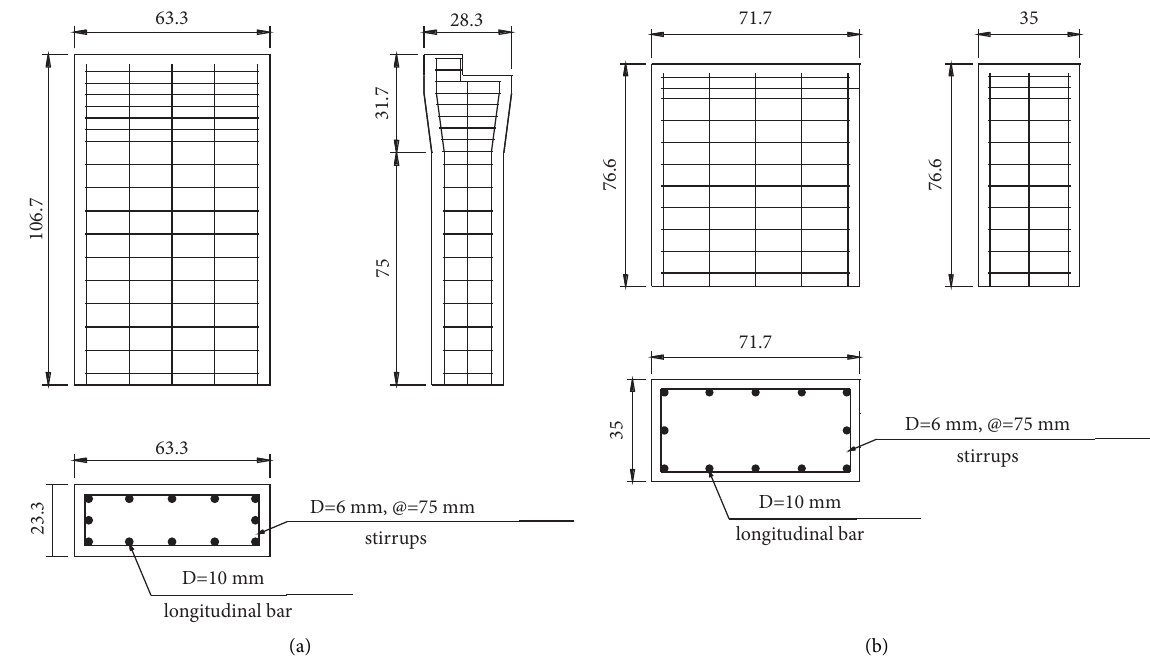
Figure 7: Specimen of pier drawings for (a) side piers (Pier-1 and Pier-4) and (b) main piers (Pier-2 and Pier-3) (unit: cm).